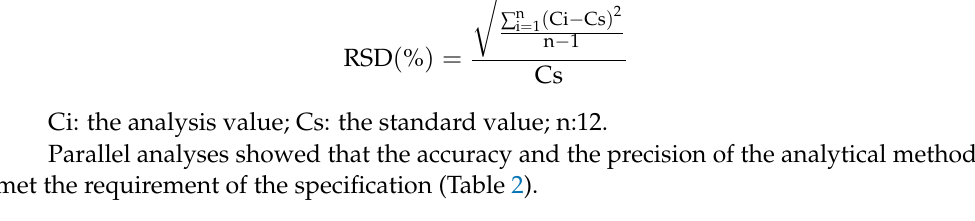
Table 2. The chromium data of standard samples.